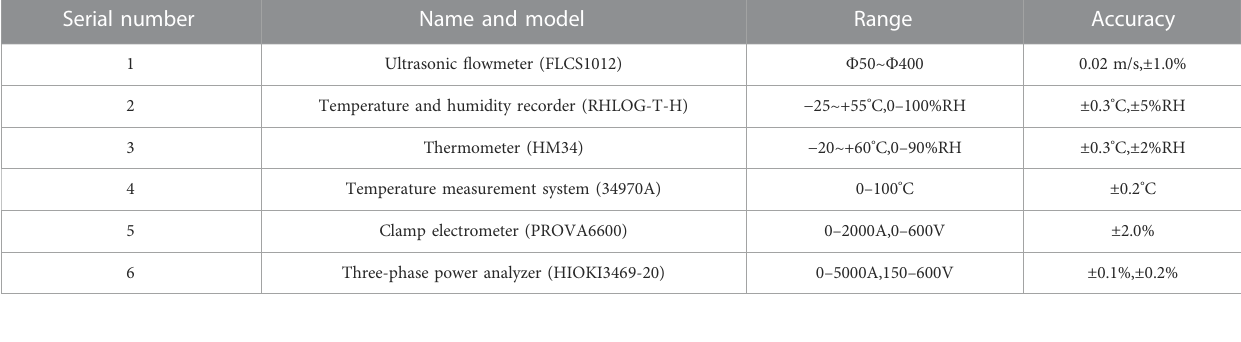
TABLE 2 Test meter.